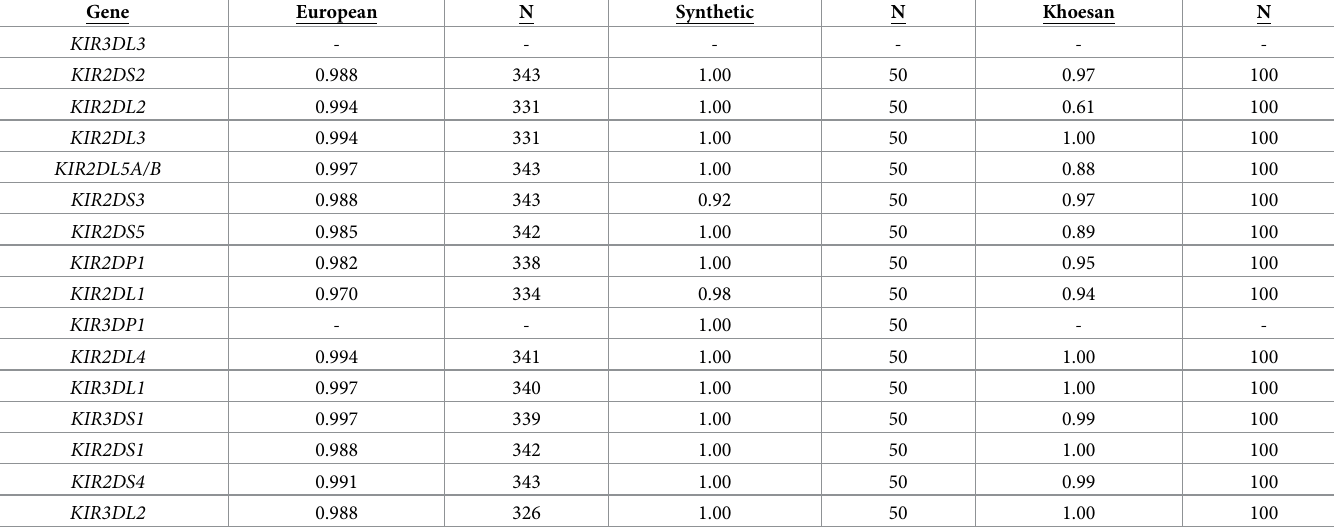
Table 1. Copy number determination performance. Concordance table comparing copy numbers determined by PING for the European reference cohort, a synthetic KIR dataset, and a Khoesan reference